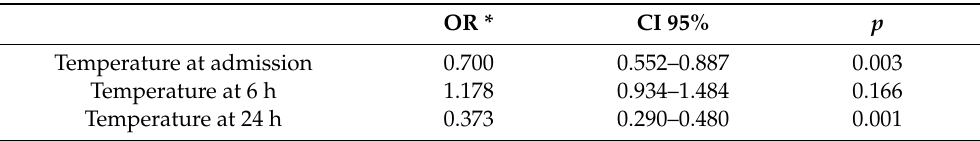
Table 2. Logistic regression model for temperature at three different time points associated with effective reperfusion.